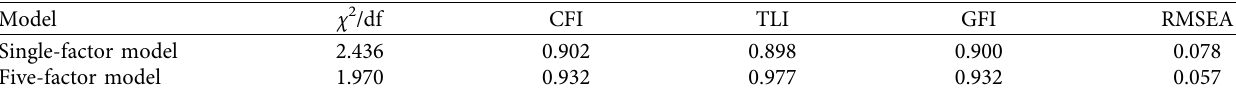
Table 3: Confirmatory factor analysis